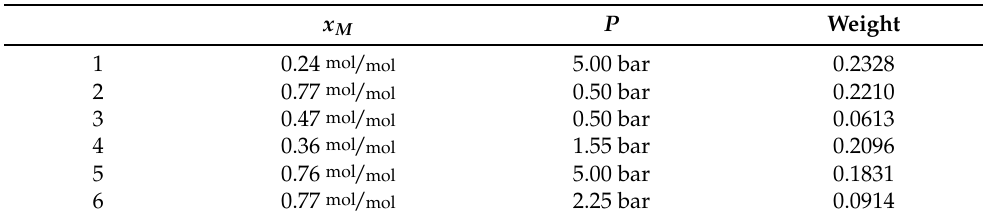
Table 7. Optimal design ξ YBT computed with the YBT algorithm for the flash with a methanol– acetone input feed.